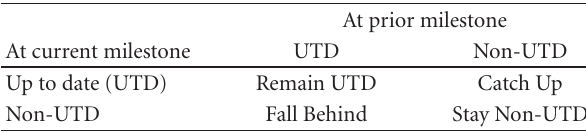
Table 2: Immunization Status Categorization. Table 3: Population Size and